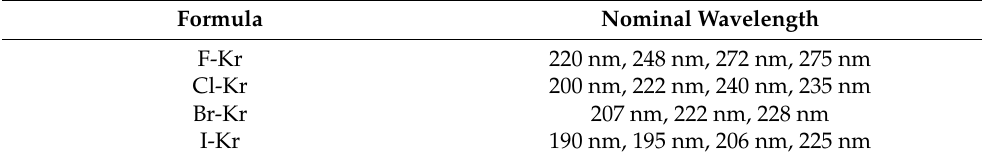
Table 1. Common formula and nominal wavelength of excimer lamp.